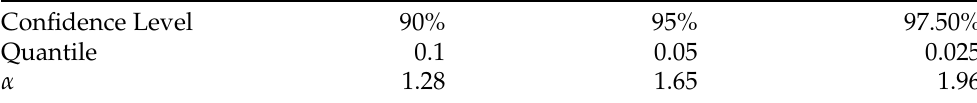
Figure 3. Concentration profiles of the two byproducts for the nominal case with maximising ethanol concentration as the objective, and minimising batch time. The blue trajectory represents the simulation with the nominal parameter value and the red trajectories depict the Monte Carlo simulations. The horizontal dashed lines depict the constraints on the byproducts. Table 3. Backoff parameter ( α ) values corresponding to the confidence